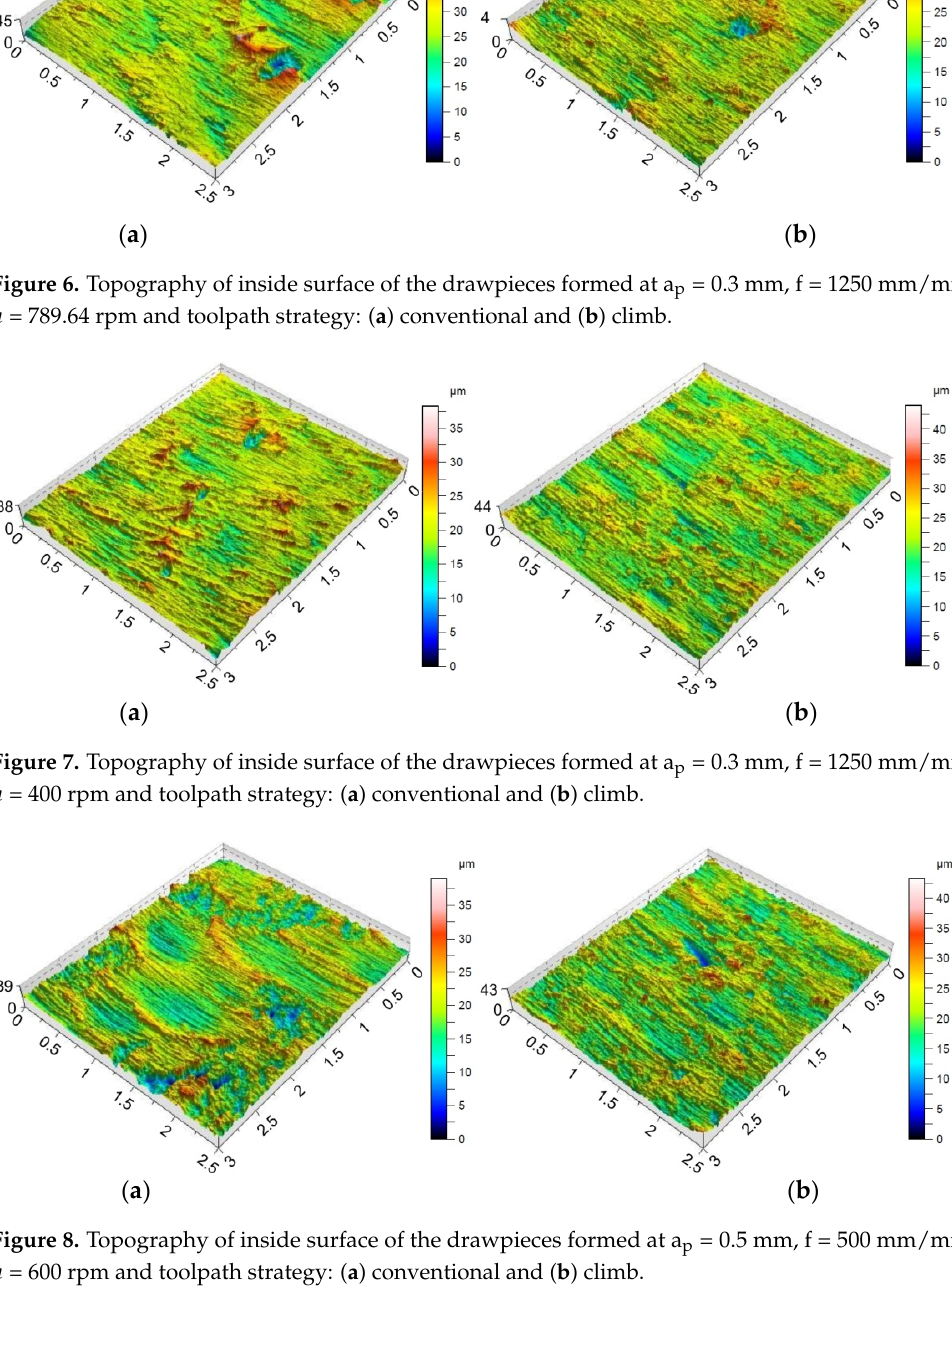
Figure 9. ( a ) SEM micrograph of the inner surface of the drawpiece formed with a p = 0.1 mm, f = 2000 mm/min and n = 600 rpm, ( b ) magnification of the A area. Figure 10. ( a ) SEM micrograph of the outer surface of the drawpiece formed with a p = 0.1 mm, f = 2000 mm/min and n = 600 rpm, ( b ) magnification of the A area.